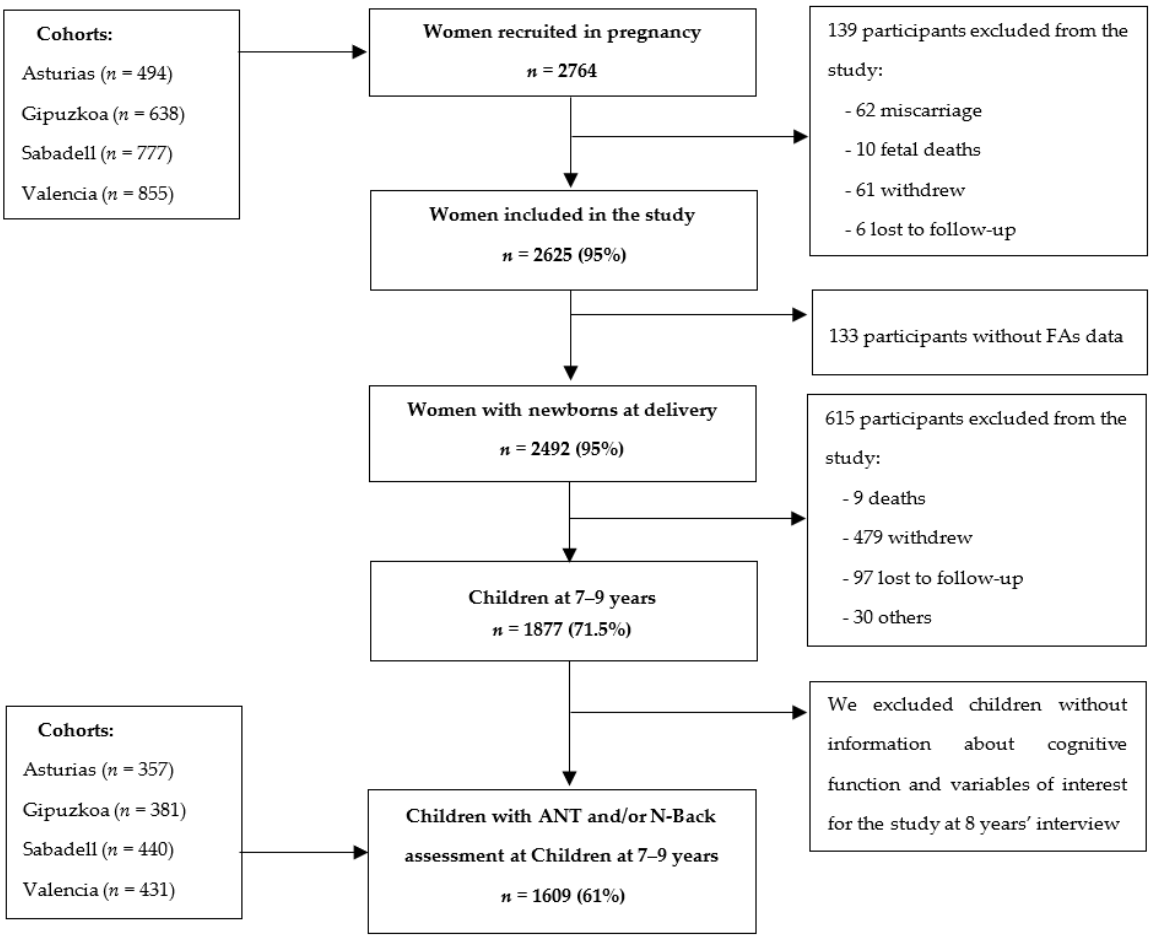
Figure 1. Flowchart of the study population in the main phases of the INMA project.